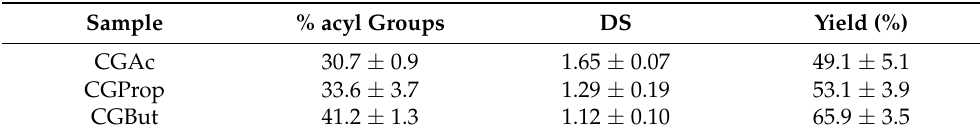
Table 1. Effect of anhydride on the degree of substitution (DS) and yield.